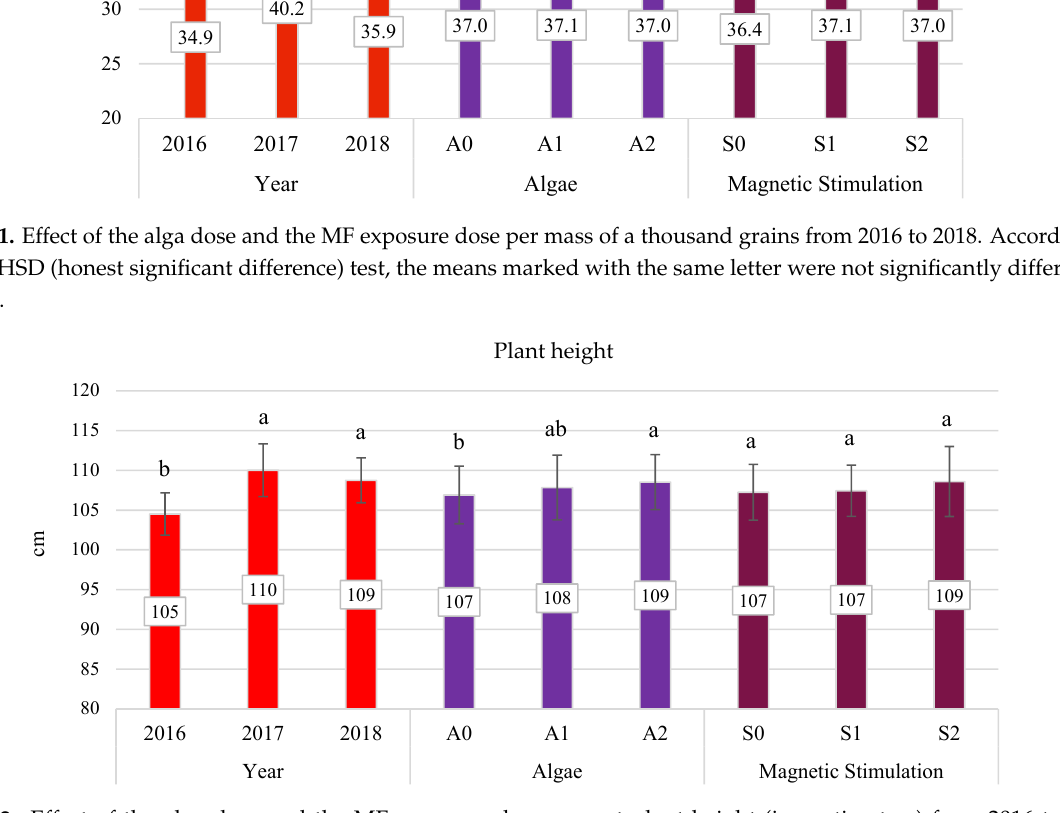
Figure 12. Effect of the alga dose and the MF exposure dose per oat plant height (in centimeters) from 2016 to 2018. According to Tukey’s HSD (honest significant difference) test, the means marked with the same letter were not significantly different at α ≤ 0.05.